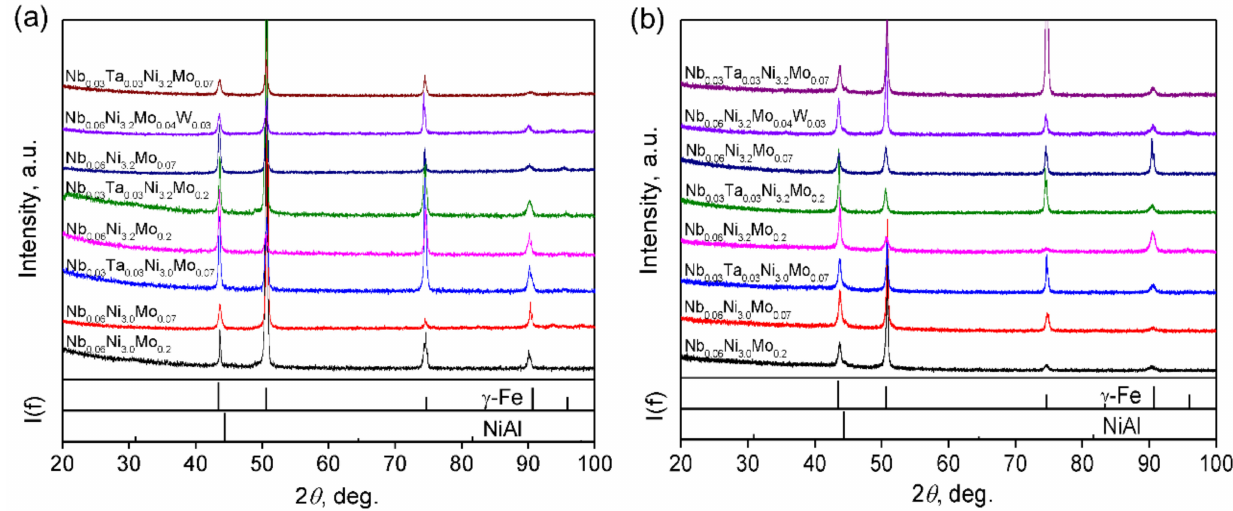
Figure 2. The XRD patterns of series-2 designed alloys after 1250 ◦ C/1.5 h solutionizing ( a ) and 800 ◦ C/24 h aging ( b ). The optical microstructures of solutionized and aged series-2 alloys are shown in Figure 3. The suction-cast ingots show typical casting microstructure, with uniform equiax- ial grains in the central region and columnar grains at the outer region. These graphs of the eight Nb x Ta 0.06 − x Ni y (Mo,W) z series-2 alloys do not show any ferritic structure, which is consistent with the XRD results. Again, the austenite stability is reached within the framework of the general cluster formula for AFA stainless steels. The SEM images of five typical compositions of series-2 alloys, Nb 0.06 Ni 3.0 Mo 0.2 (2- 1), Nb 0.06 Ni 3.0 Mo 0.07 (2-2), Nb 0.03 Ta 0.03 Ni 3.2 Mo 0.2 (2-5), Nb 0.06 Ni 3.2 Mo 0.04 W 0.03 (2-7) and Nb 0.03 Ta 0.03 Ni 3.2 Mo 0.07 (2-8), are shown in Figure 4. The secondary electron